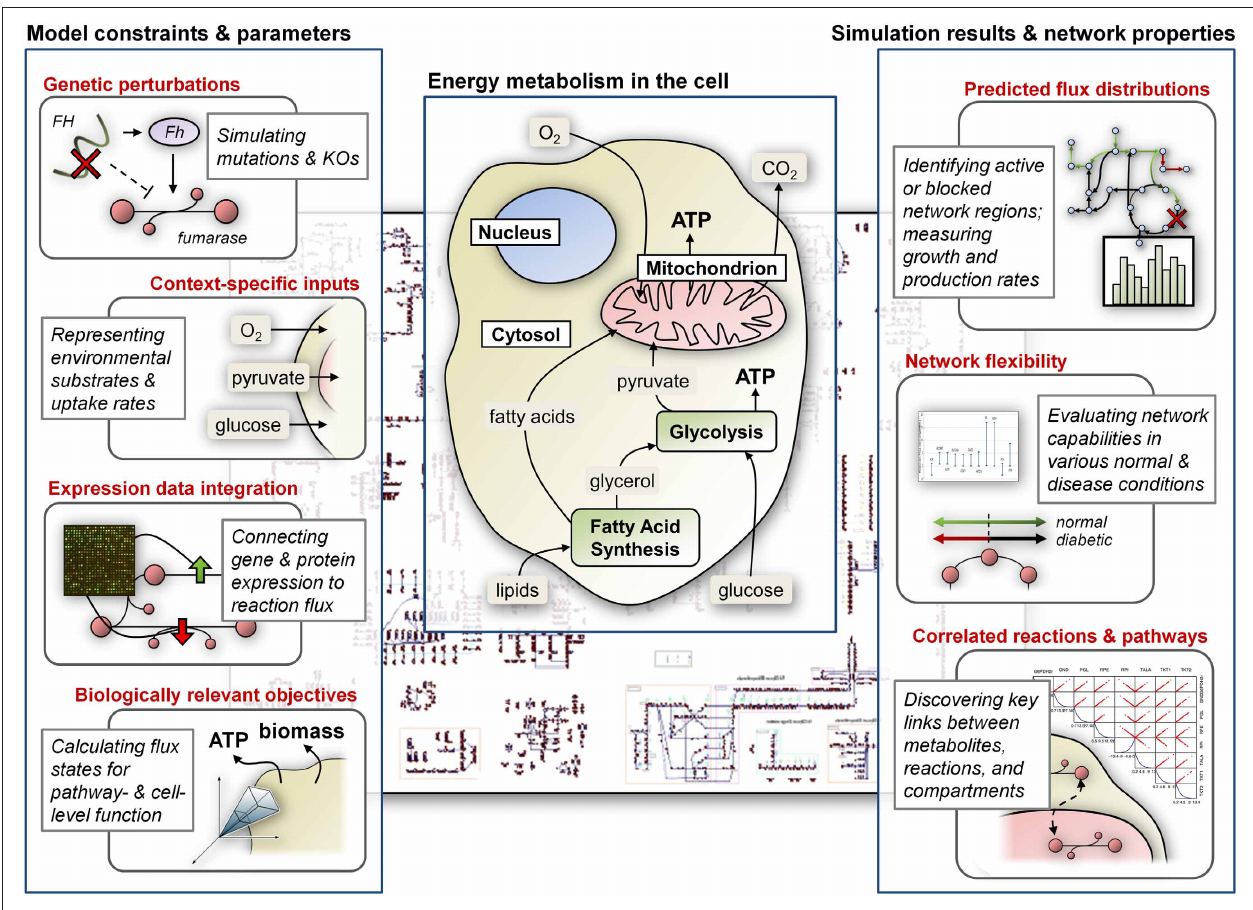
FIGURE 1 | CB modeling of energy metabolism. Constraints and condition-specific parameters are most commonly represented as bounds on the flux through reactions in the network; optimizing for specific cellular objectives identifies network states that satisfy